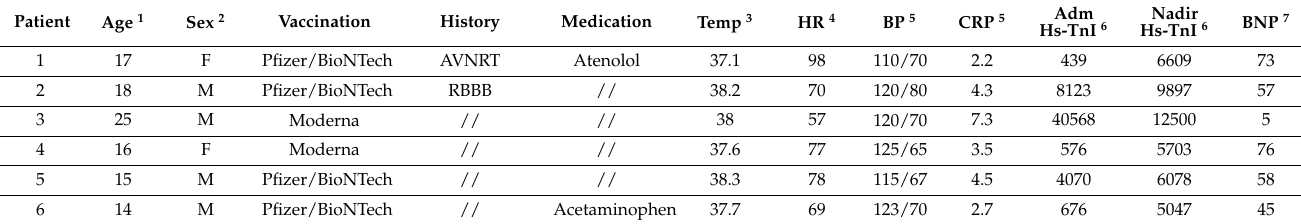
Table 1. General characteristics of patients hospitalized due to vaccine-related myocardial involve- ment at the CMR